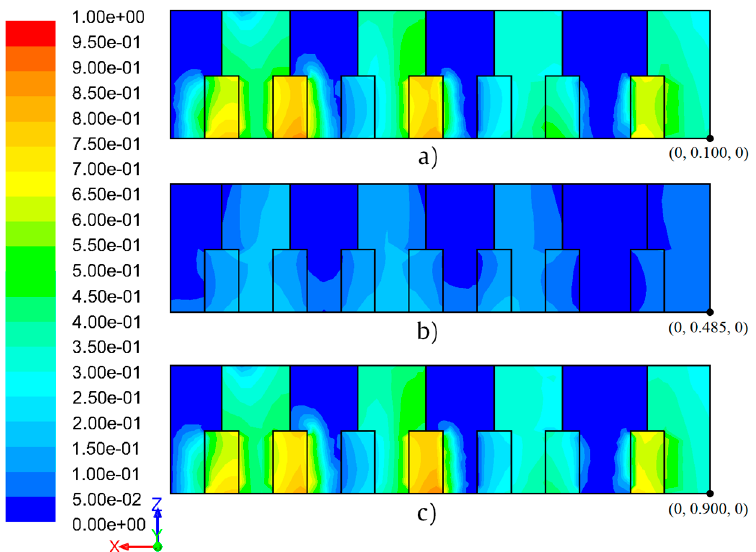
Figure 5. The results of the field of temperature in the x-z plane through the planes: ( a ) y adm = 0.100; ( b ) y adm = 0.485; and ( c ) y adm = 0.900.